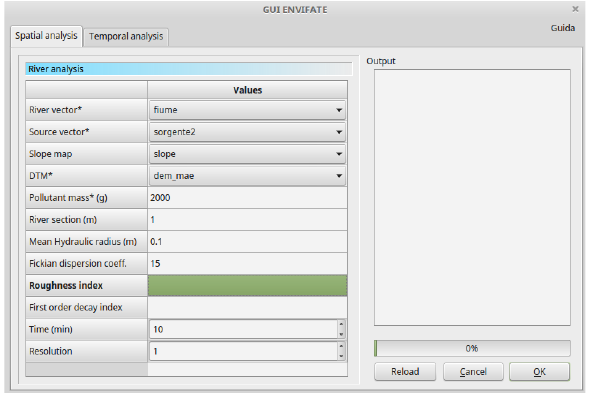
Figure 2. An example of ENVIFATE GUI.